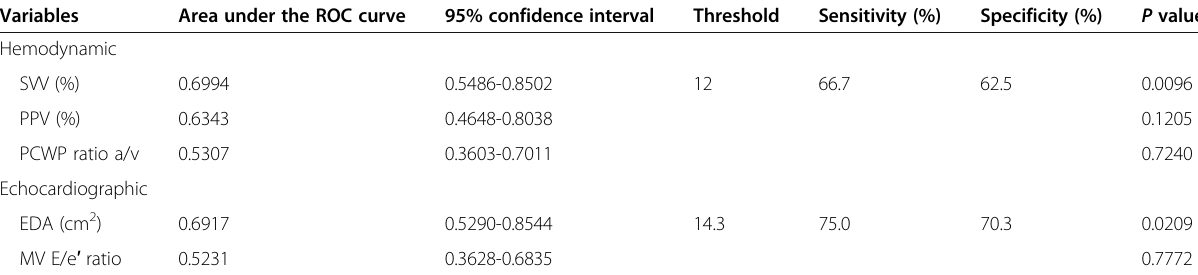
Table 4 Areas under the receiver operating characteristic (ROC) curves generated for hemodynamic and echocardiographic parameters to predict changes in cardiac